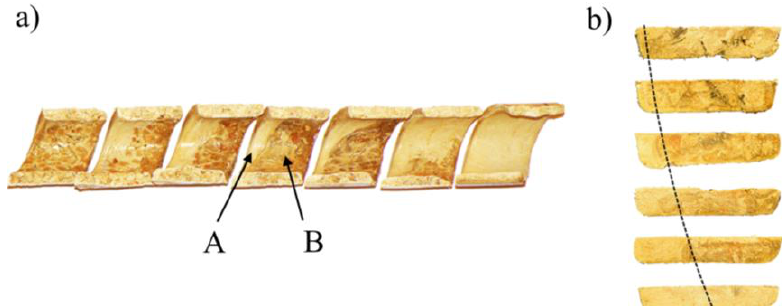
Figure 5. Mechanism of melting of wood – plastic composite (WPC) in the single-screw extruder: ( a ) a view from the screw side (WF = 40%), ( b ) cross sections (WF = 30%); A — molten material, B — solid material.